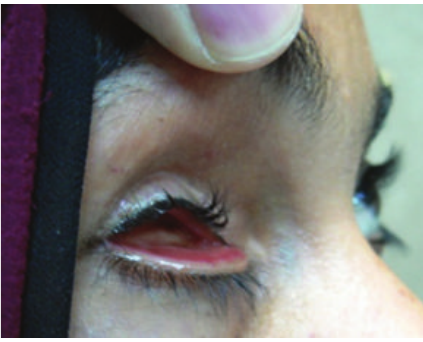
Figure 1: Patient with anophthalmic socket syndrome having shallow inferior fornix and lax lower eyelid.